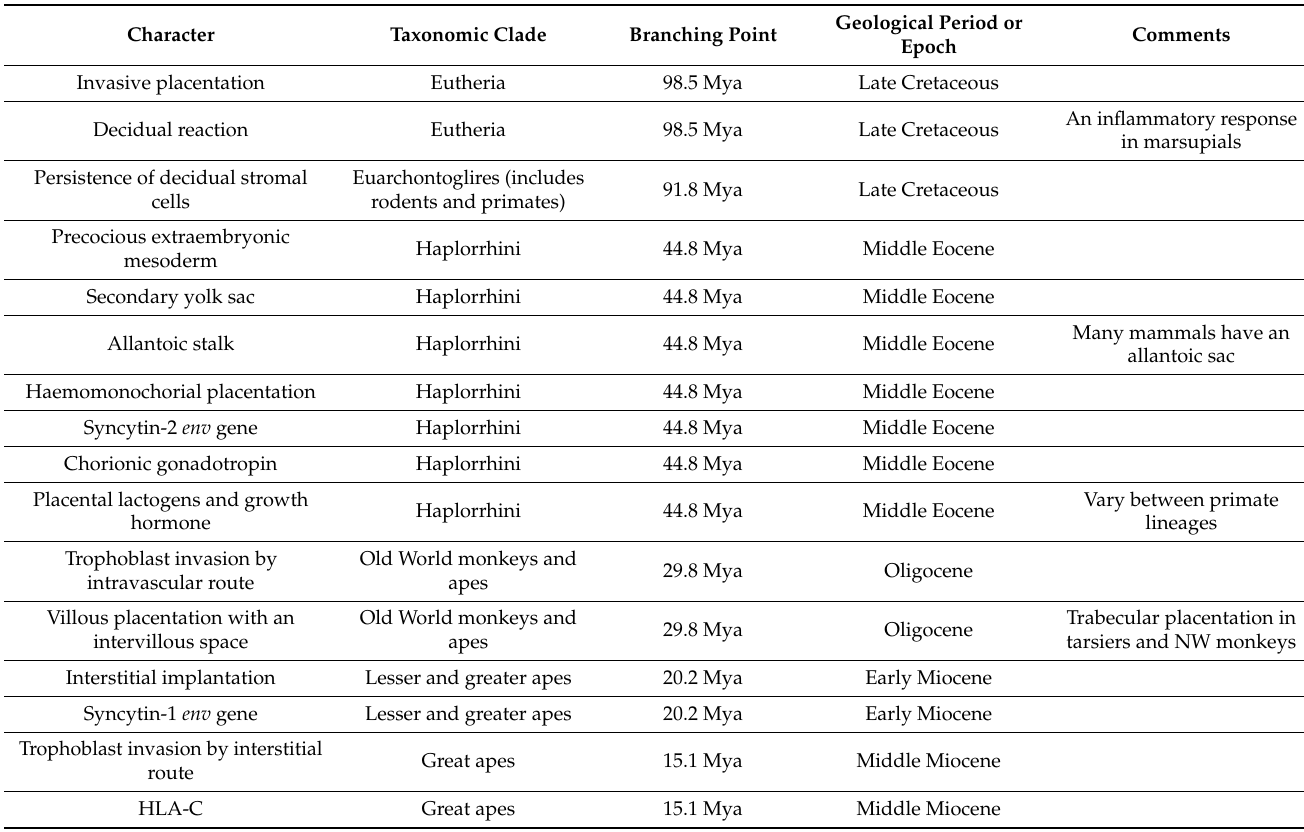
Table 2. Characteristics of human placentation and their estimated appearance during evolution. Branching points (Mya, million years ago) are estimates based on molecular data